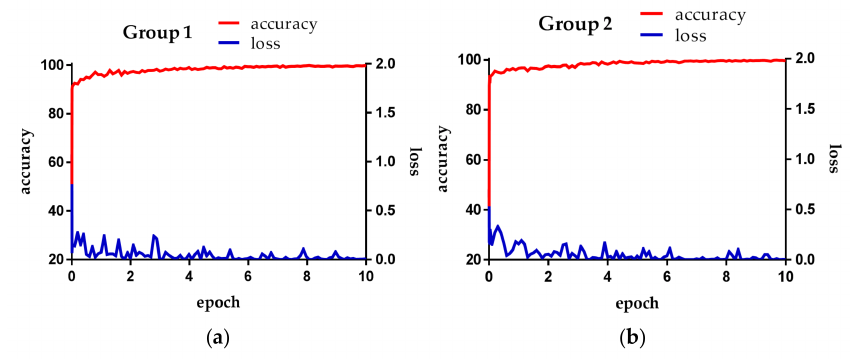
Figure 5. Training loss and accuracy per epoch: ( a ) First-fold cross validation; ( b ) second-fold cross validation.